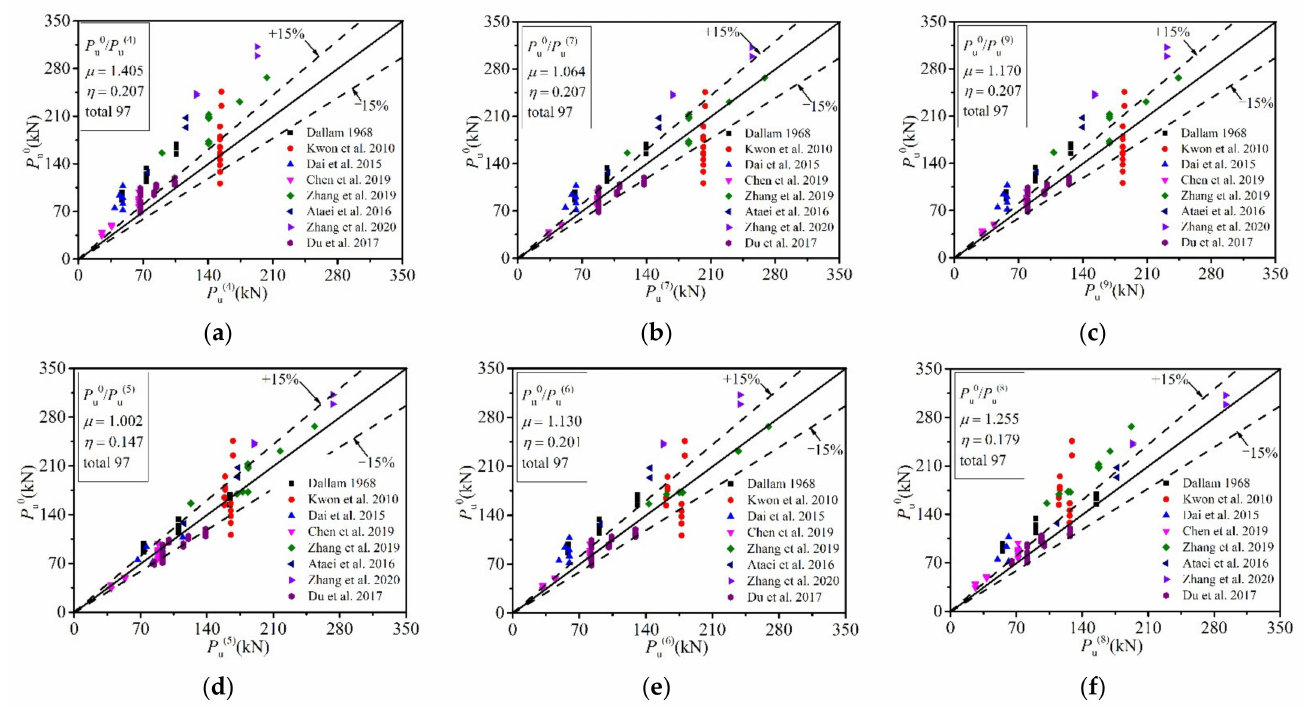
Figure 18. Comparison of shear strength between the predicted and tests: ( a ) Equation (4); ( b ) Equation (7); ( c ) Equation (9); ( d ) Equation (5); ( e ) Equation (6); ( f ) Equation (8).